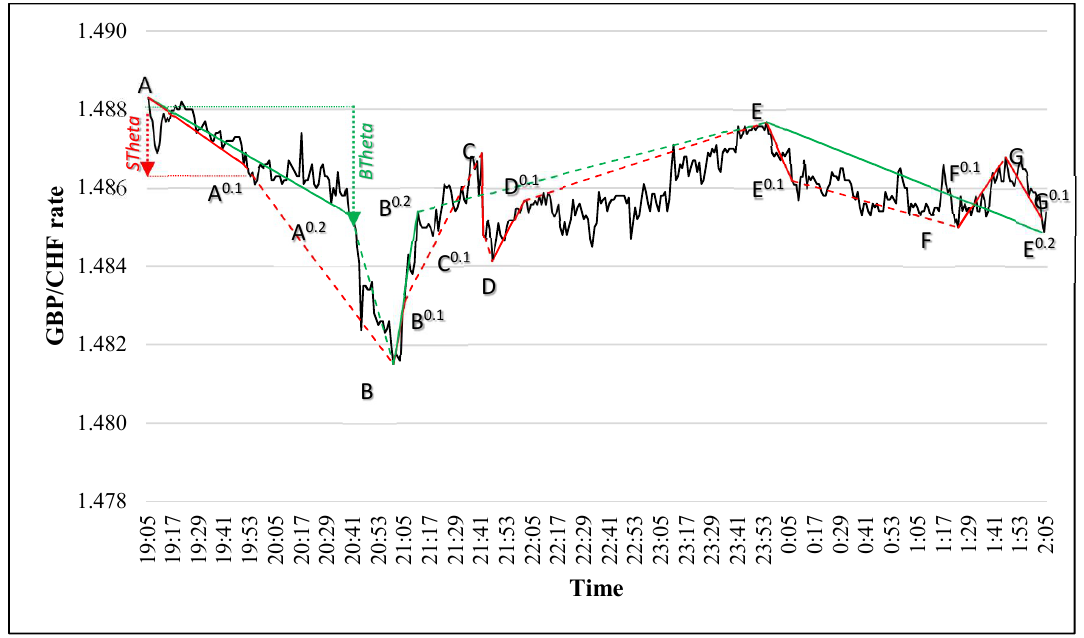
Figure 4. The synchronization of two DC summaries with two thresholds: STheta = 0.1% (in red lines) and BTheta = 0.2% (in green) for GBP/CHF rate sampled minute by minute from 1 January 2013 19:05:00 to 1 February 2013 02:05:00. Source: Bakhach et al. [6].